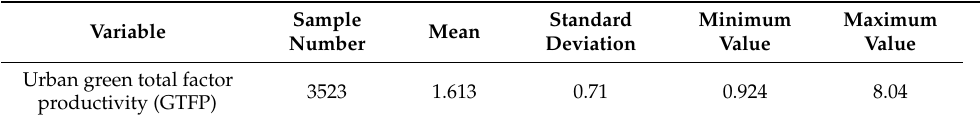
Table 7. Descriptive statistics of GTFP with GML index.